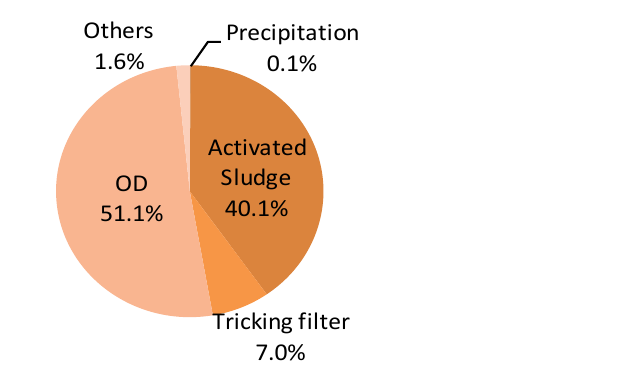
Figure 10. Adoption ratio of treatment processes in sewer systems in